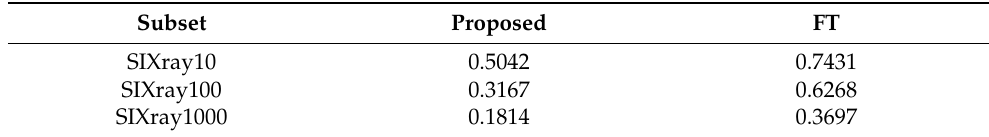
Table 3. Performance comparison on L CL on the SIXray subsets in terms of the F1-score. All scores were computed for the best-performing ResNet101 model.